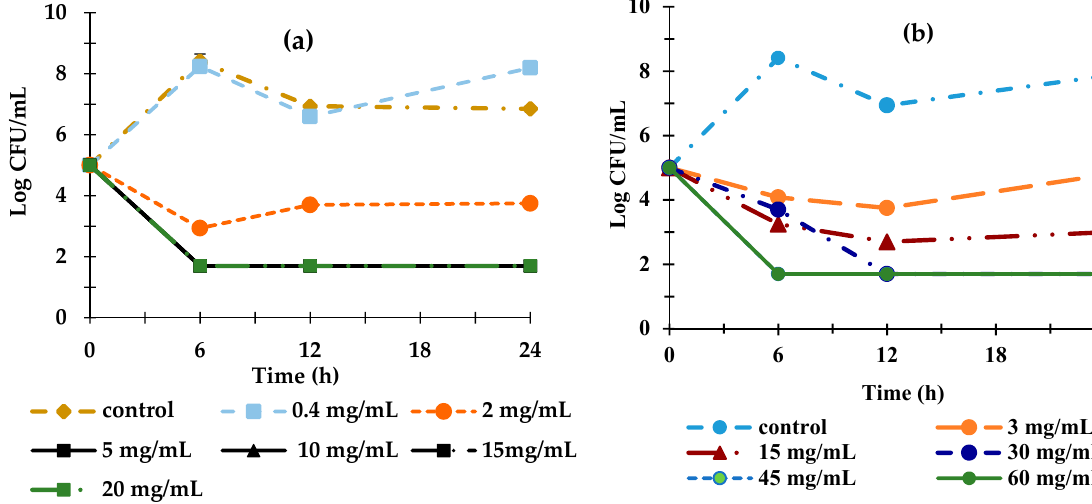
Figure 1. Minimum inhibitory concentration (mg / mL) of MOEO ( a ) and BEO ( b ) against Escherichia coli O157:H7.